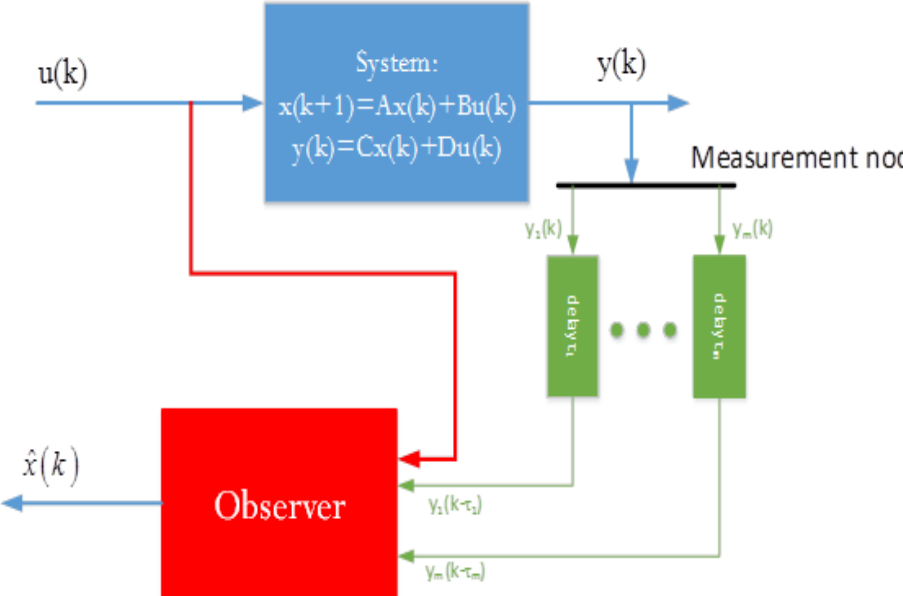
Figure 1. Schematic showing the transmission lines with measurement delays.